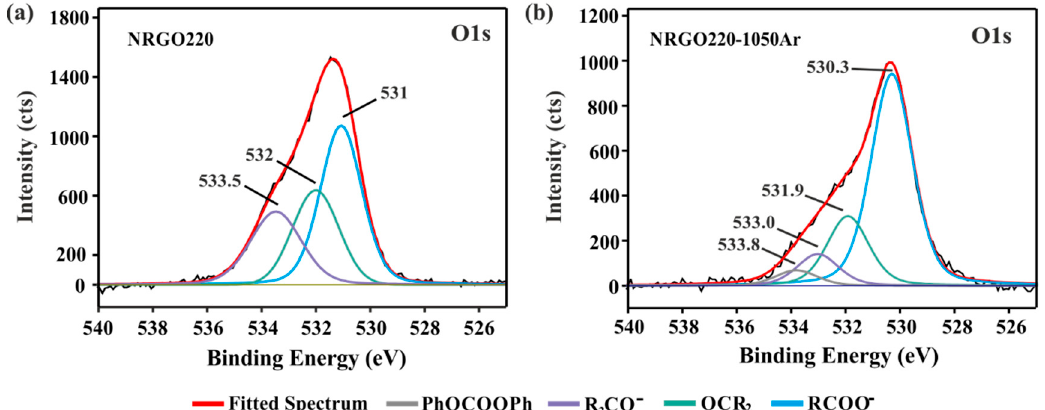
Figure 5. High resolution O1s spectra of ( a ) NRGO220 and ( b ) NRGO220-1050Ar.